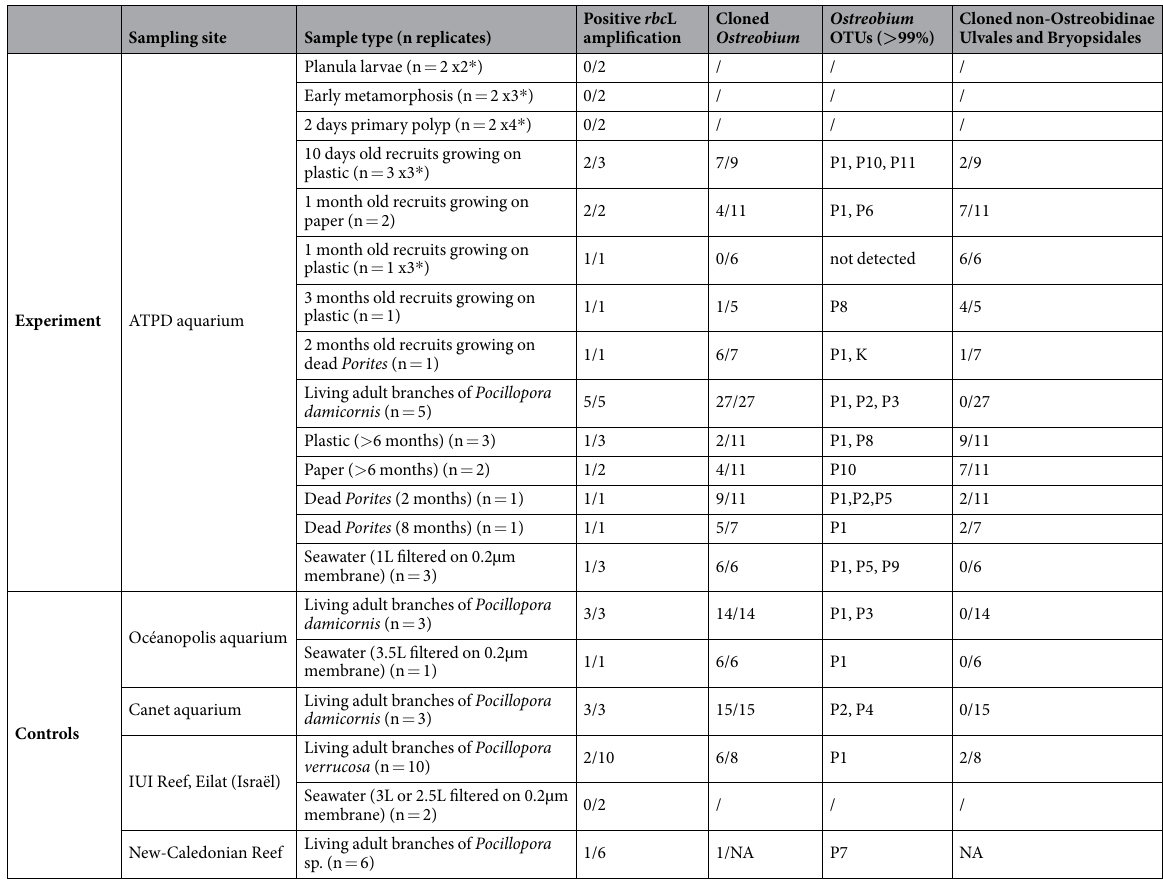
Table 1. Coral samples and environmental controls used for rbc L detection of dominant Ostreobium clades. ( * ) early coral life stages were pooled by 2–4 individuals to increase biomass for DNA extraction. NA = non- available